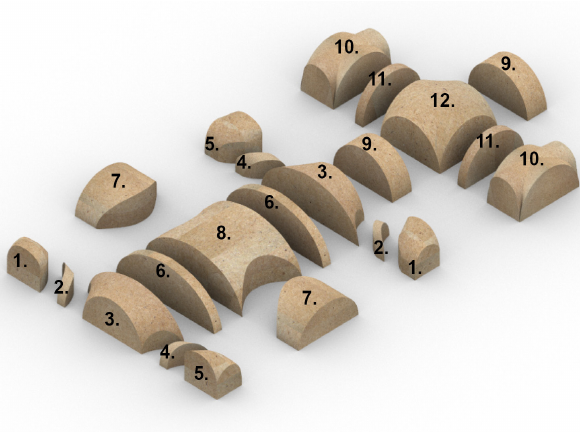
Figure 8 . Mesh joinery approach applied to the vault of Palazzo Mazzonis atrium. Digital prototyping: F. Ronco.